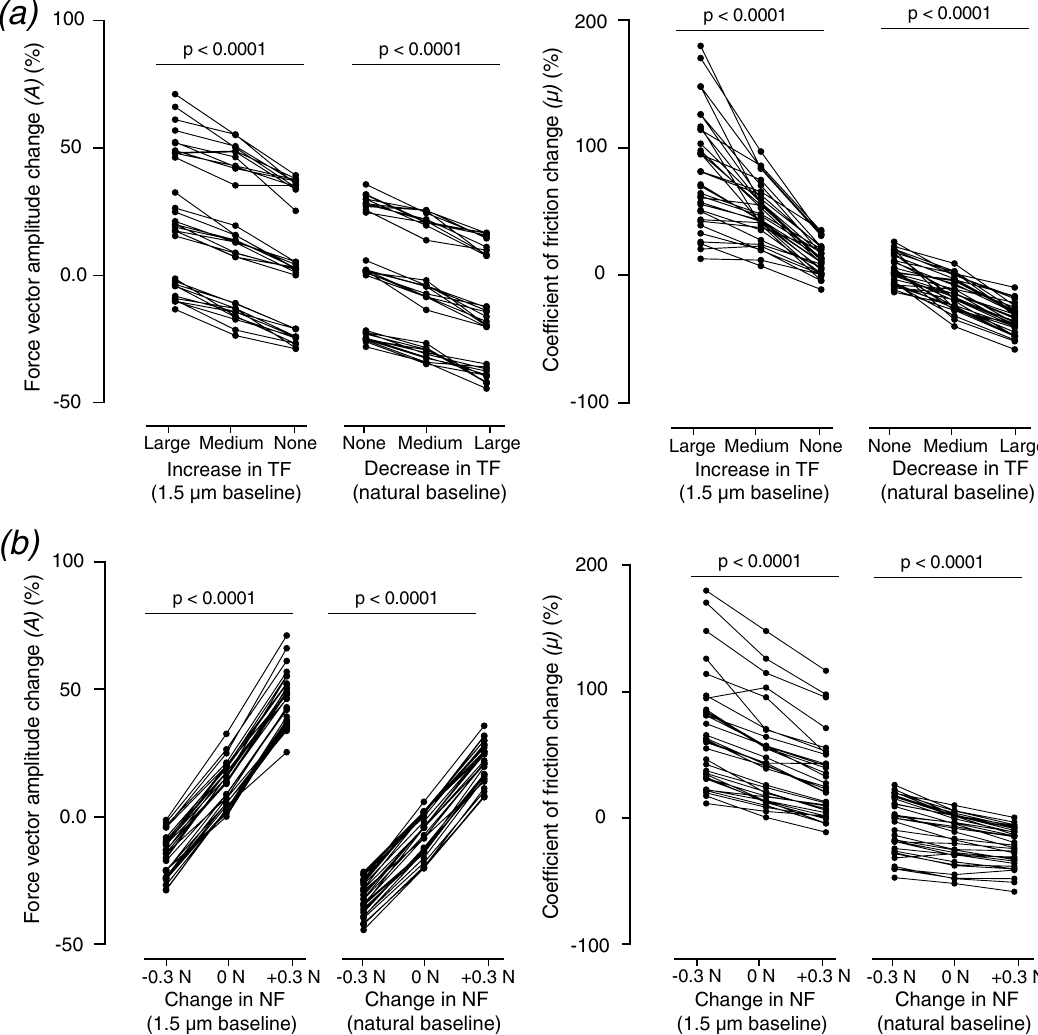
Figure 4. ( a ) Changes across TF conditions for the two metrics. Individual points represent the averaged change for one participant in a given condition. Lines connect conditions from the same participant with identical baseline and variation of normal force. ( b ) Same plot for the change across NF conditions. Lines connect conditions from the same participant with identical baseline and ultrasonic